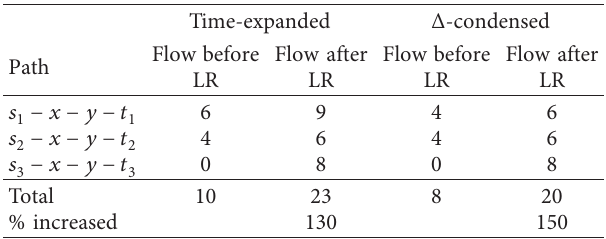
Figure 5: Δ -condensed time-expanded network of Figure 1(b) after scaling capacity and transit time. Table 2: Maximum multicommodity flow over time with lane reversals.